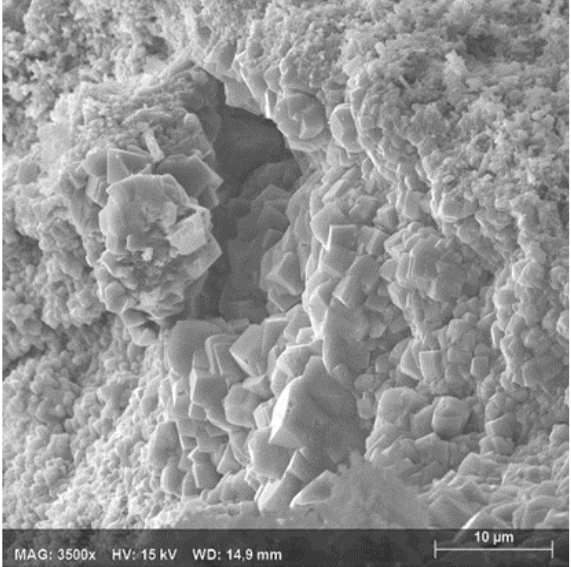
Figure 14. SEM image with a magnification of the 3500x and a working distance (WD) of 14.9 mm at A+Q30%:M 2 mortar where it is possible to observe the large capillary pores filled by carbonate crystals after cycles.